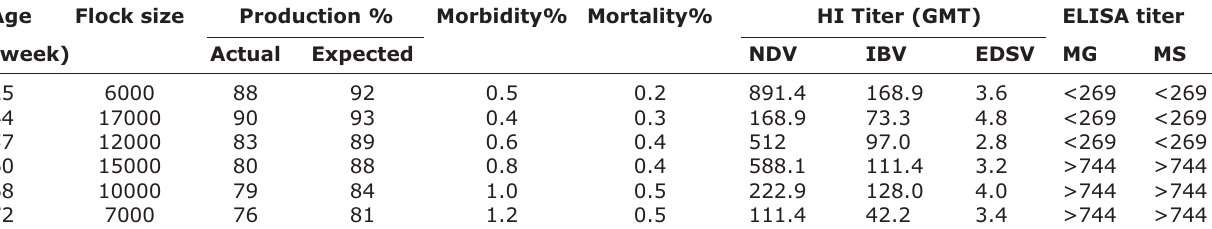
Table-1: Flock details and antibody titer in layer chicken affected with oviduct impaction. Age Flock